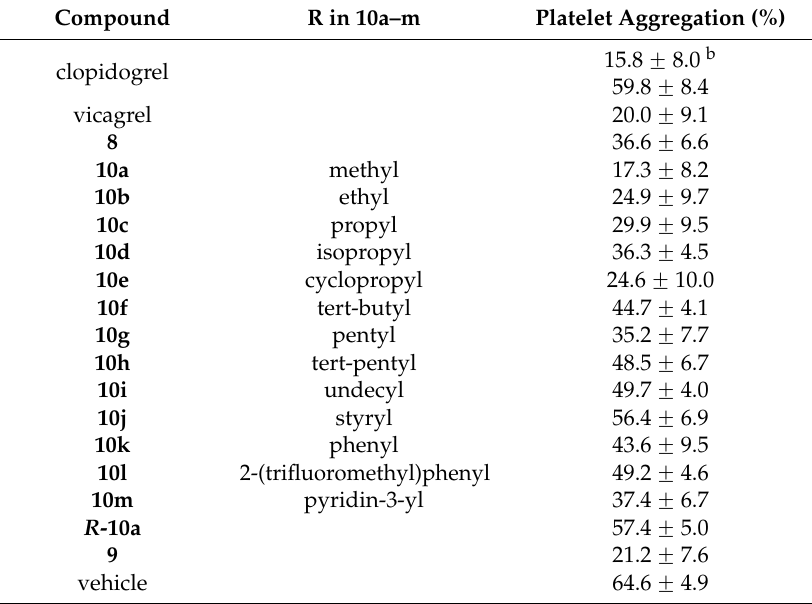
Table 1. Inhibitory effects of clopidogrel- and vicagrel-related compounds on ADP-induced platelet aggregation in rat ex vivo a .